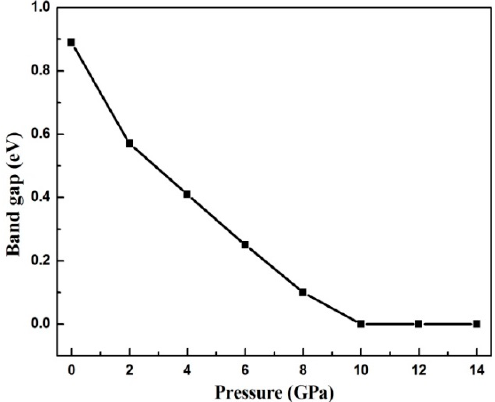
Figure 5. Relationship between the energy bandgap of GeSe and the applied pressure.